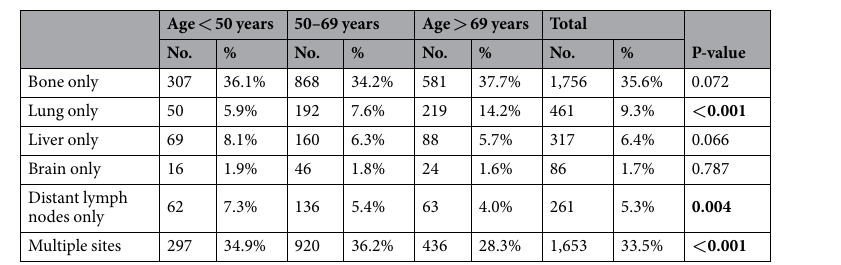
Table 2. The number and proportion of breast cancer patients with single metastatic site and multiple metastatic